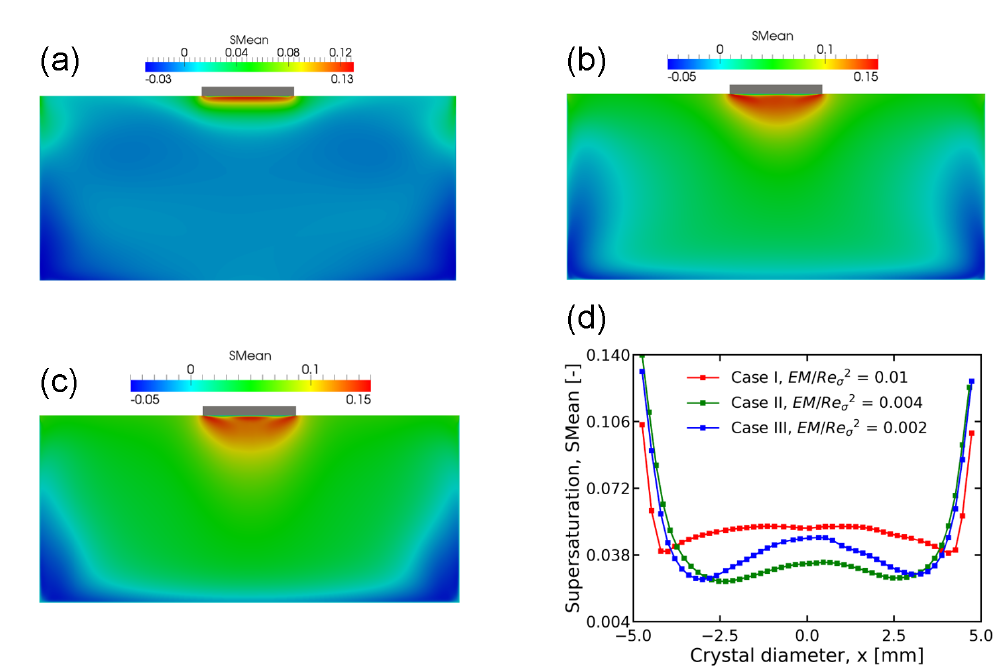
Figure 6. Time-averaged supersaturation distribution in the melt at the vertical side for ( a ) Case 1, ( b ) Case 2, and ( c ) Case 3; ( d ) the computed supersaturation profiles in the melt along the seed